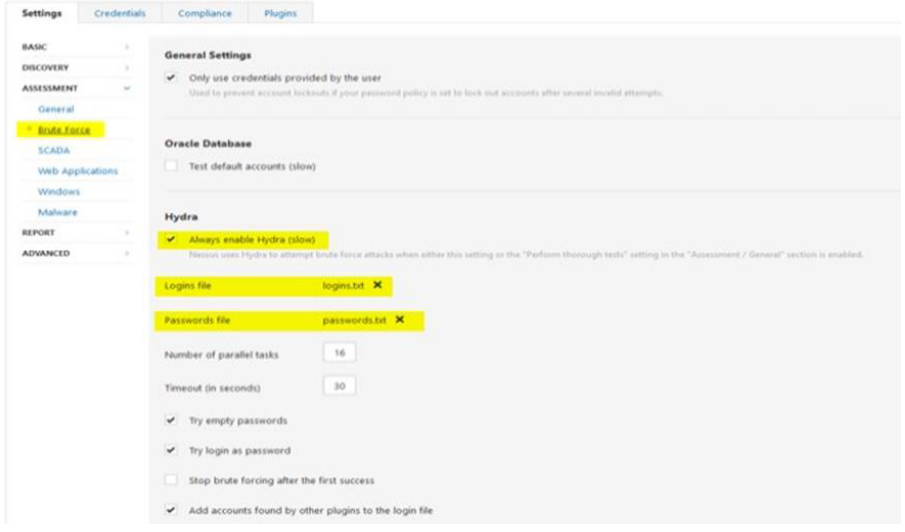
Figure 3. A sample of Nessus feature can cause crash .